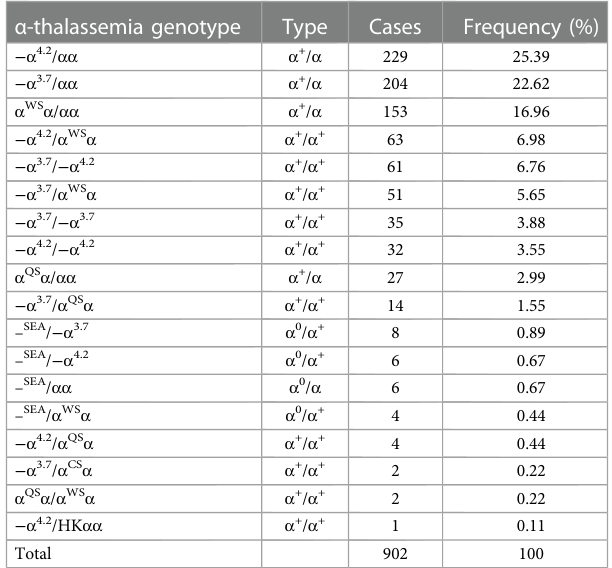
TABLE 2 Distribution of α -thalassemia genotypes in the newborns of Li in Hainan